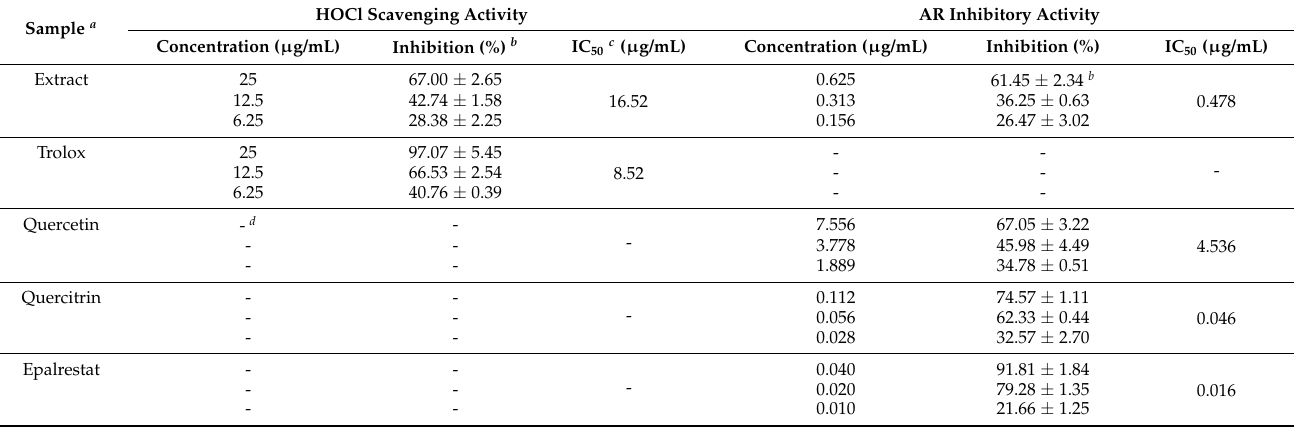
Table 1. Hypochlorous acid scavenging and AR inhibitory activity of the 70% MeOH root extract of V.